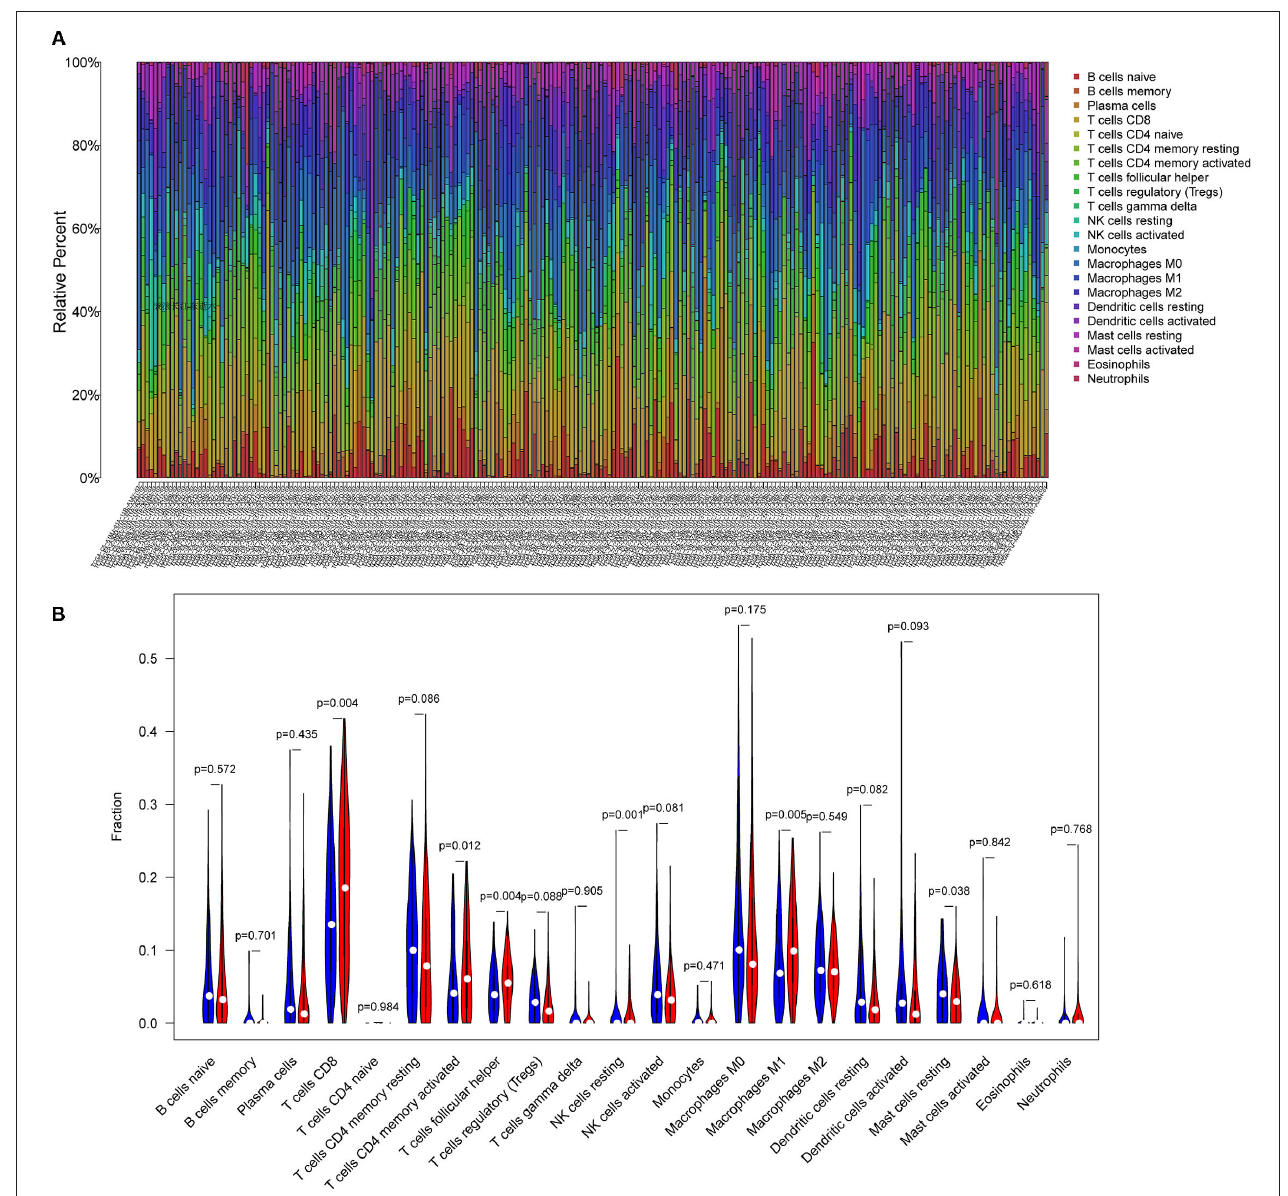
FIGURE 4 | Differential infiltration of tumor-infiltrating immune cells in different TMB groups. (A) Stacked bar plot representing the relative proportion of 22 immune cell types in each sample. (B) Violin plot showing the differential infiltration of 22 immune cells between the high TMB and low TMB groups. In red, the high TMB group and in blue, the low TMB